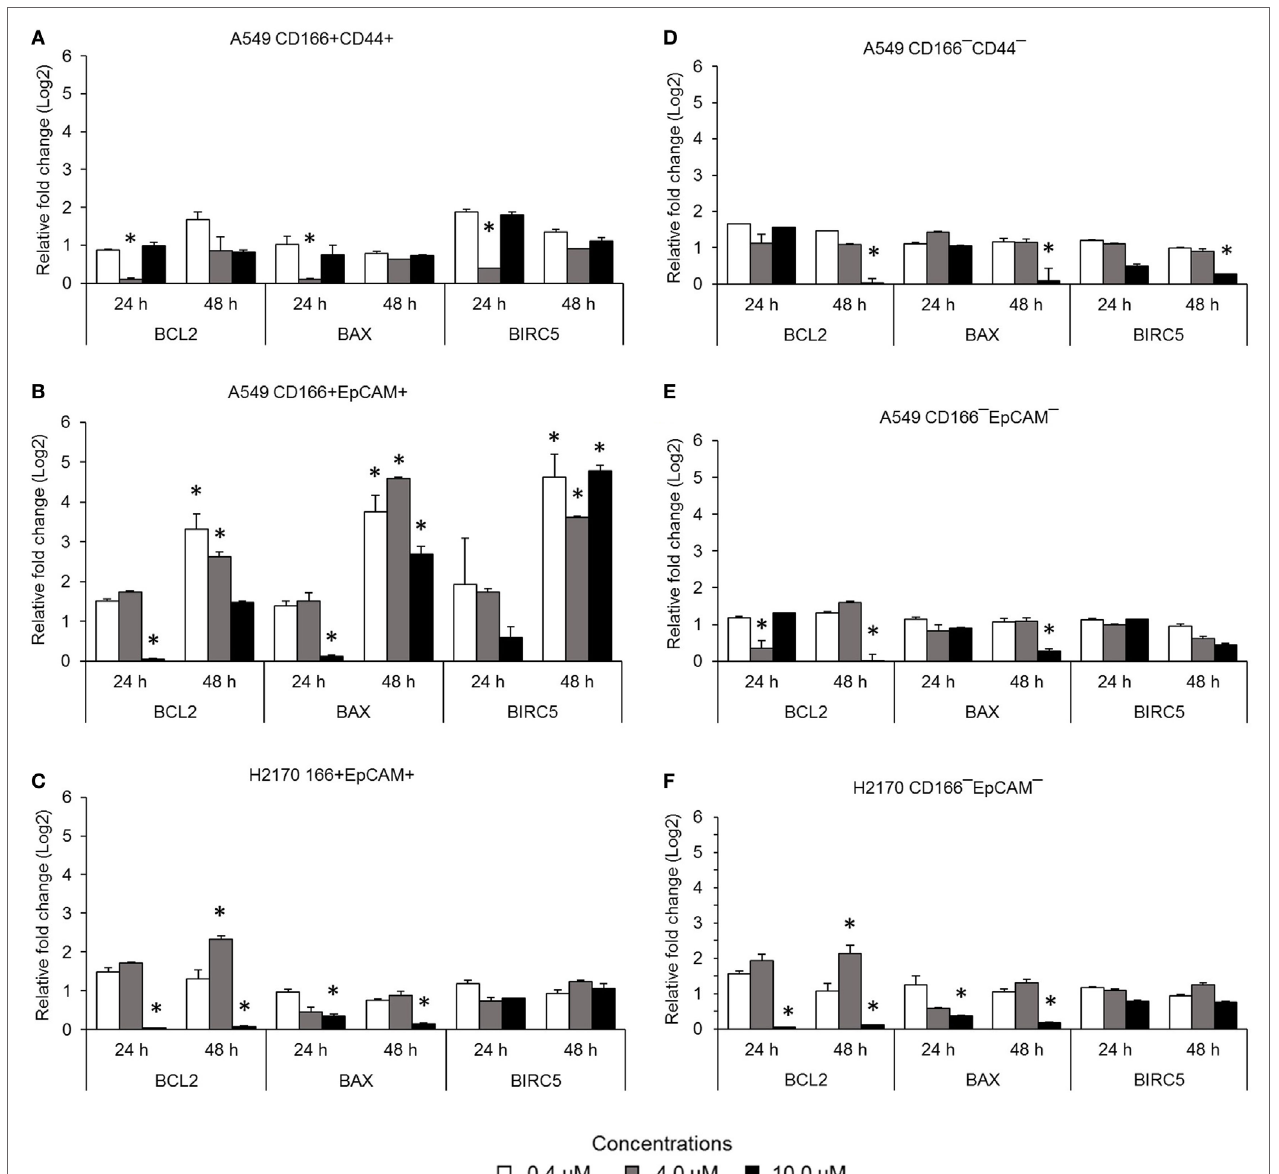
FigUre 3 | Expression of pro-apoptotic genes ( BCL-2 and BIRC5 ) and the anti-apoptotic gene BAX in lung cancer stem cells following treatment with different concentrations of BMS-345541. Relative expression of BCL2, BAX , and BIRC5 in (a) A549 CD166 + CD44 + ; (B) A549 CD166 + EpCAM + ; (c) H2170 CD166 + EpCAM + ; (D) A549 CD166 − CD44 − ; (e) A549 CD166 − EpCAM − ; and (F) H2170 CD166 − EpCAM − cells. The fold change was calculated using the 2 −ΔΔ ct formula, and GAPDH was used as the internal control. The results represent the mean ± SD of three replicates. The p -value was calculated using analysis of variance by comparing the treatment groups with the untreated group (* p <